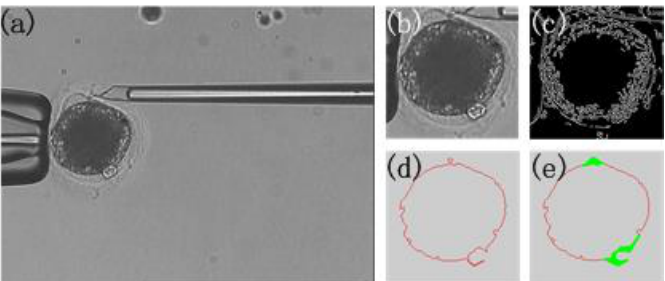
Figure 8. Prediction result. ( a ) Microscopic image; ( b ) The oocyte area; ( c ) Edge detection result; ( d ) The contour of the oocyte; ( e ) The prediction